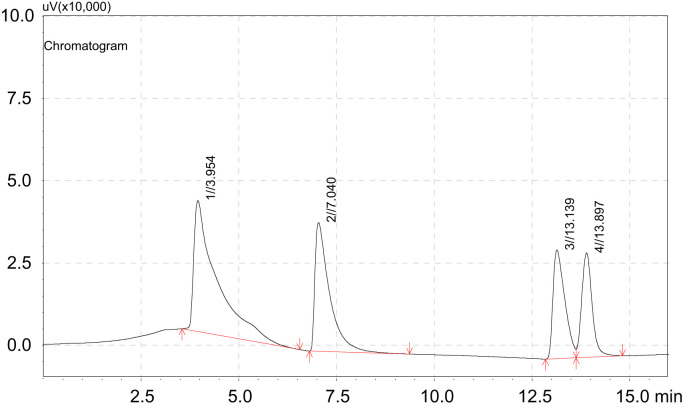
Sample standard.